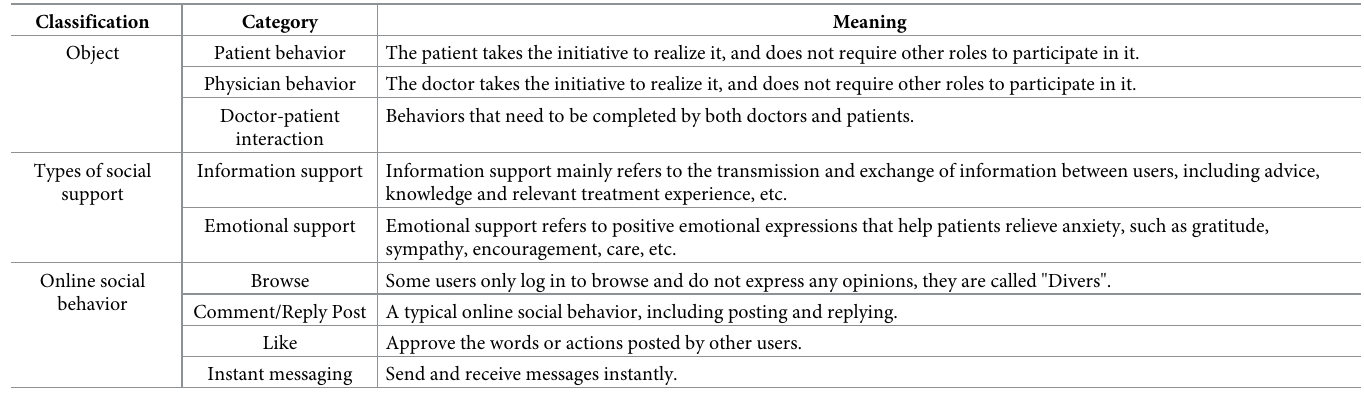
Table 1. Types of user participation behaviors in online health